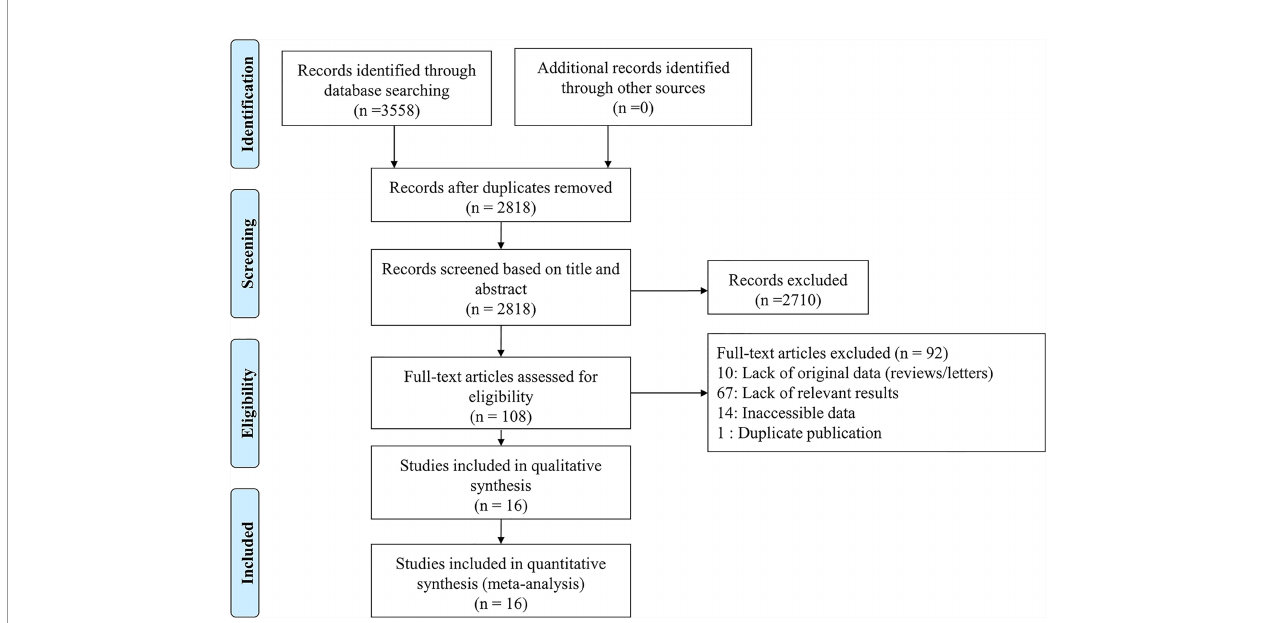
FIGURE 1 | Flow diagram of study